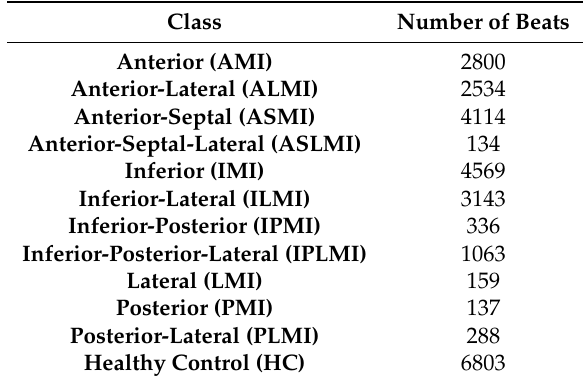
Table 1. Number of beats for different types of MI and healthy subjects in this